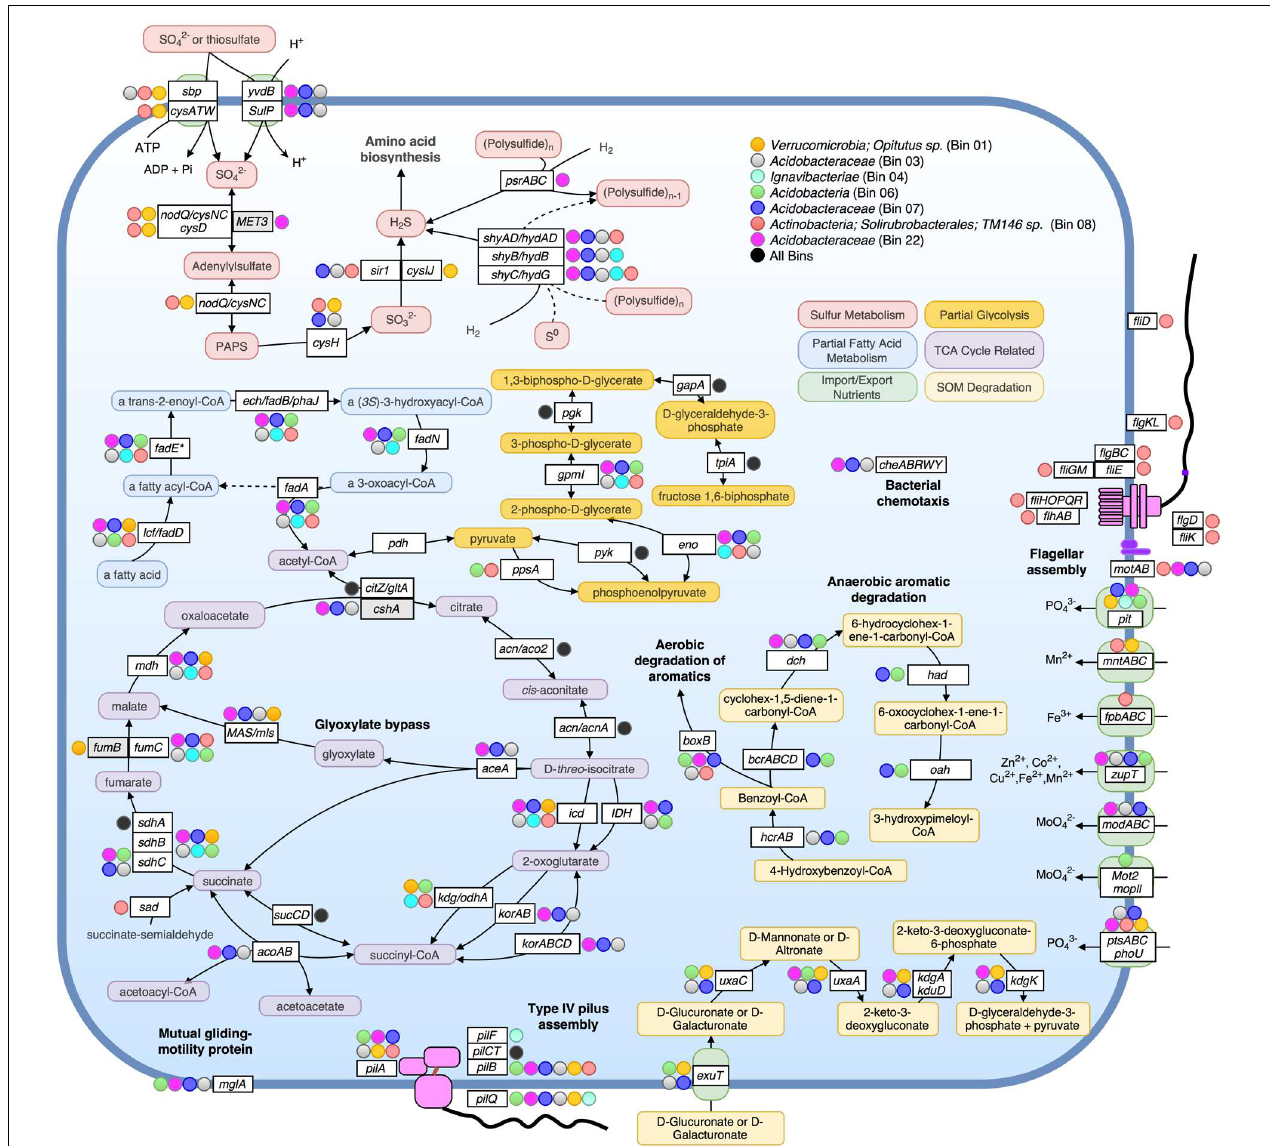
FIGURE 4 | Metabolic pathways identified in seven assembled population bins. Selected metabolic transformations and other cellular activities are represented by both the name of the gene known to encode the protein enzyme for them as well as the substrate of the enzyme. Protein enzymes were identified by searching predicted proteins against Swiss-Prot database, as well as by searching against close representatives of selected organisms: Acidobacteria Ca. Solibacter usitatus Ellin6076 and Ca. Koribacter versatilis Ellin345 for bins 03, 06, 07, and 22; Chlorobi Ignavibacterium album JCM 16511 for bin 04; Verrucomicrobium Opitutus terrae PB90-1 for Bin 01. In all instances besides zupT , mglA , phoU , sad , and pit, pathways were only displayed if all or most genes of an operon involved in the same pathway/process were detected as present. Colored circles alongside genes indicate that the bin assigned to that color (see legend on top right)